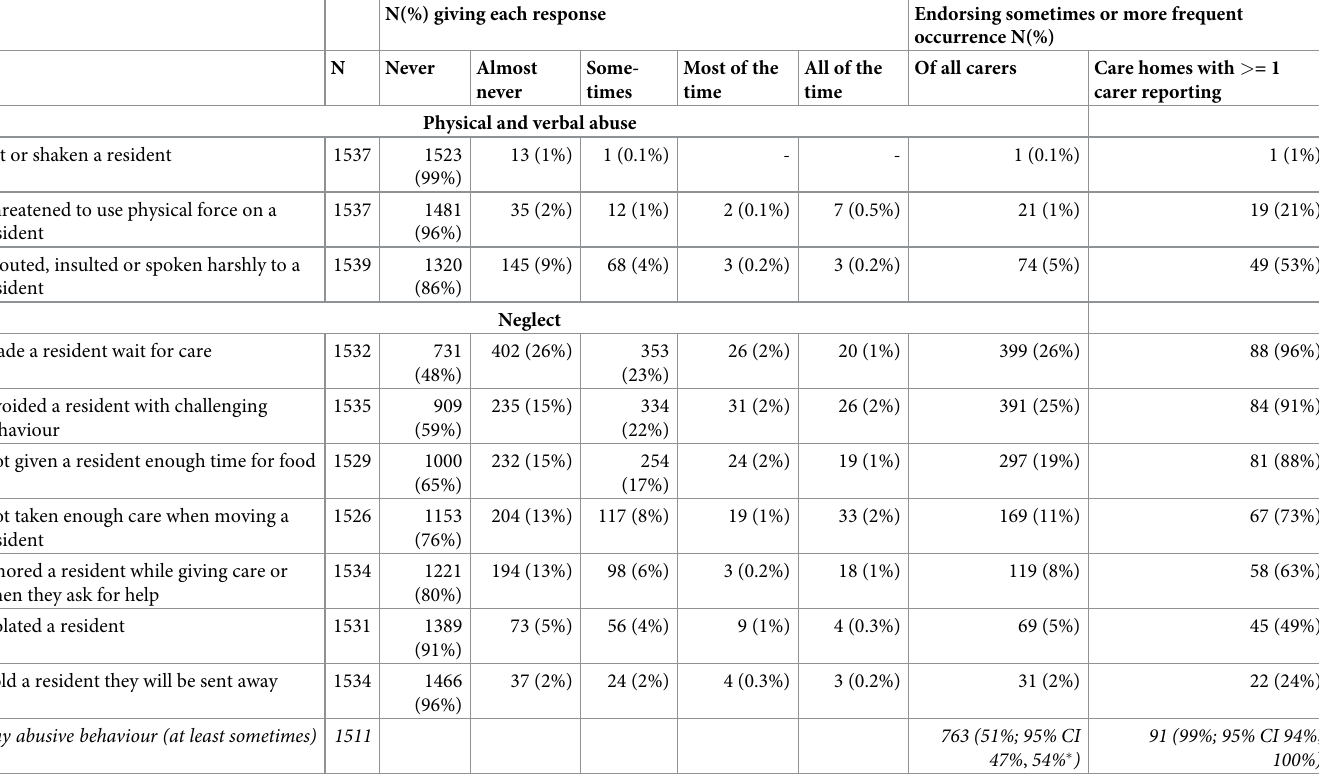
Table 3. Number (%) of care home staff reporting that they had seen or carried out each of the potentially abusive behaviours studied at least sometimes in the last 3